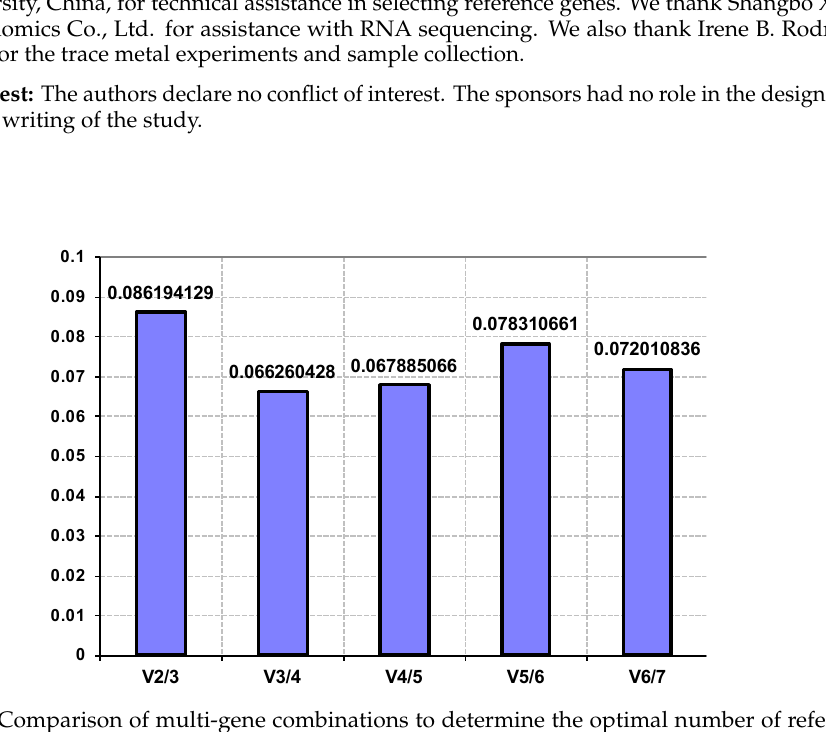
Figure A1. Comparison of multi-gene combinations to determine the optimal number of reference genes required for effective normalizing gene expression. The pairwise variation (Vn/Vn + 1, where n represent number of genes) between the normalization factors NF n and NF n + 1 was analyzed using geNorm. All the combinations gave a normalization factor value below the upper threshold 0.15, indicating that two-gene combinations are sufficient.